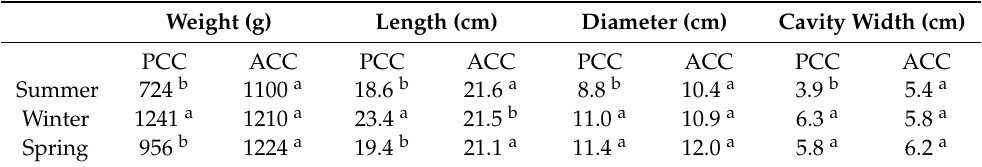
Table 3. Fruit size parameters in “Siluet” papaya grown in passive climate control (PCC) and active climate control (ACC) modules (fruit harvested in summer 2017, winter and spring 2018 when skin was 50% yellow).